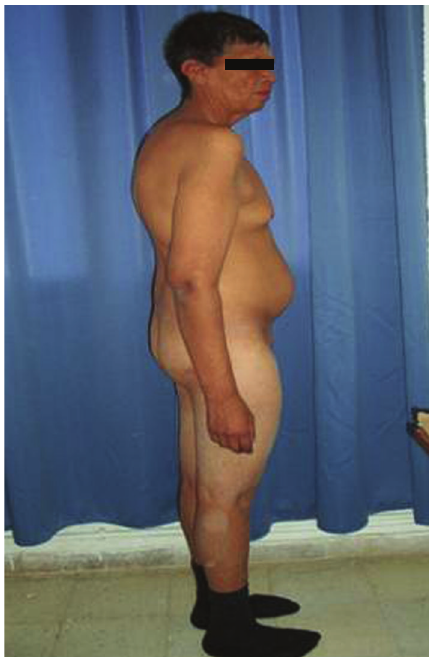
Figure 3: Lateral physical appearance. Note the android obesity.